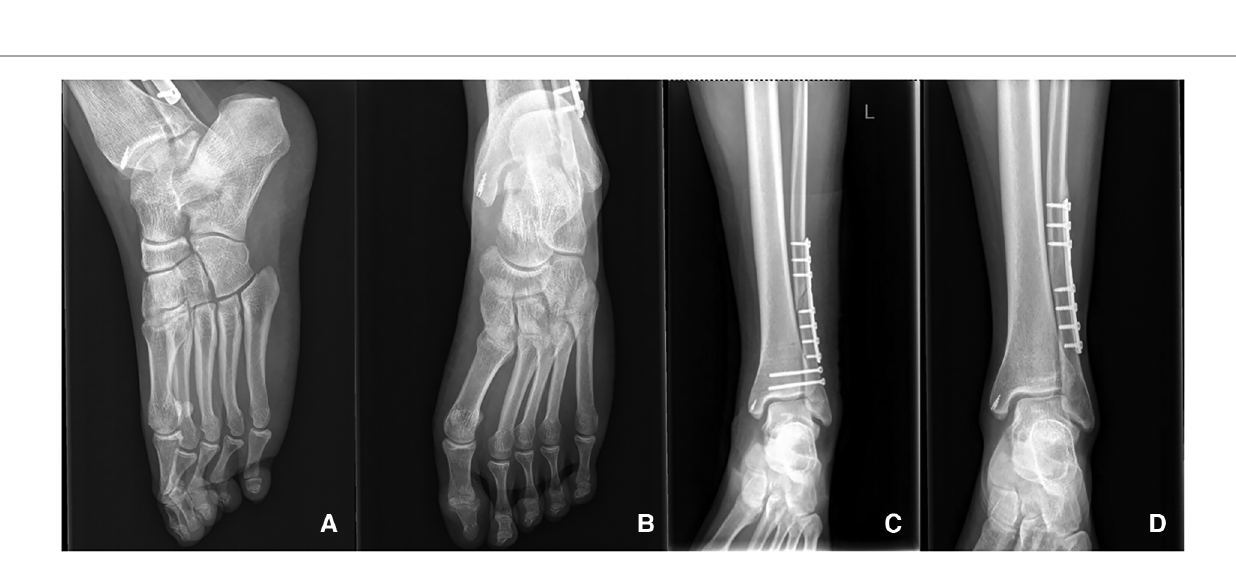
FIGURE 2 X-ray of the left foot and ankle 32 months after the primary operation. No dislocation of the IP and MP joints ( A,B ) and synostosis formation at the fracture site or interosseous membrane ( D ) was observed. Syndesmotic screws ( C ) were removed at postoperative 10 weeks after primary operation.